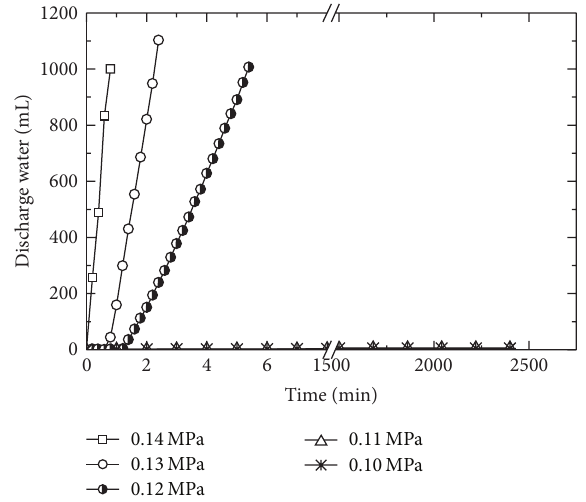
Figure 8: Results of the air pressure